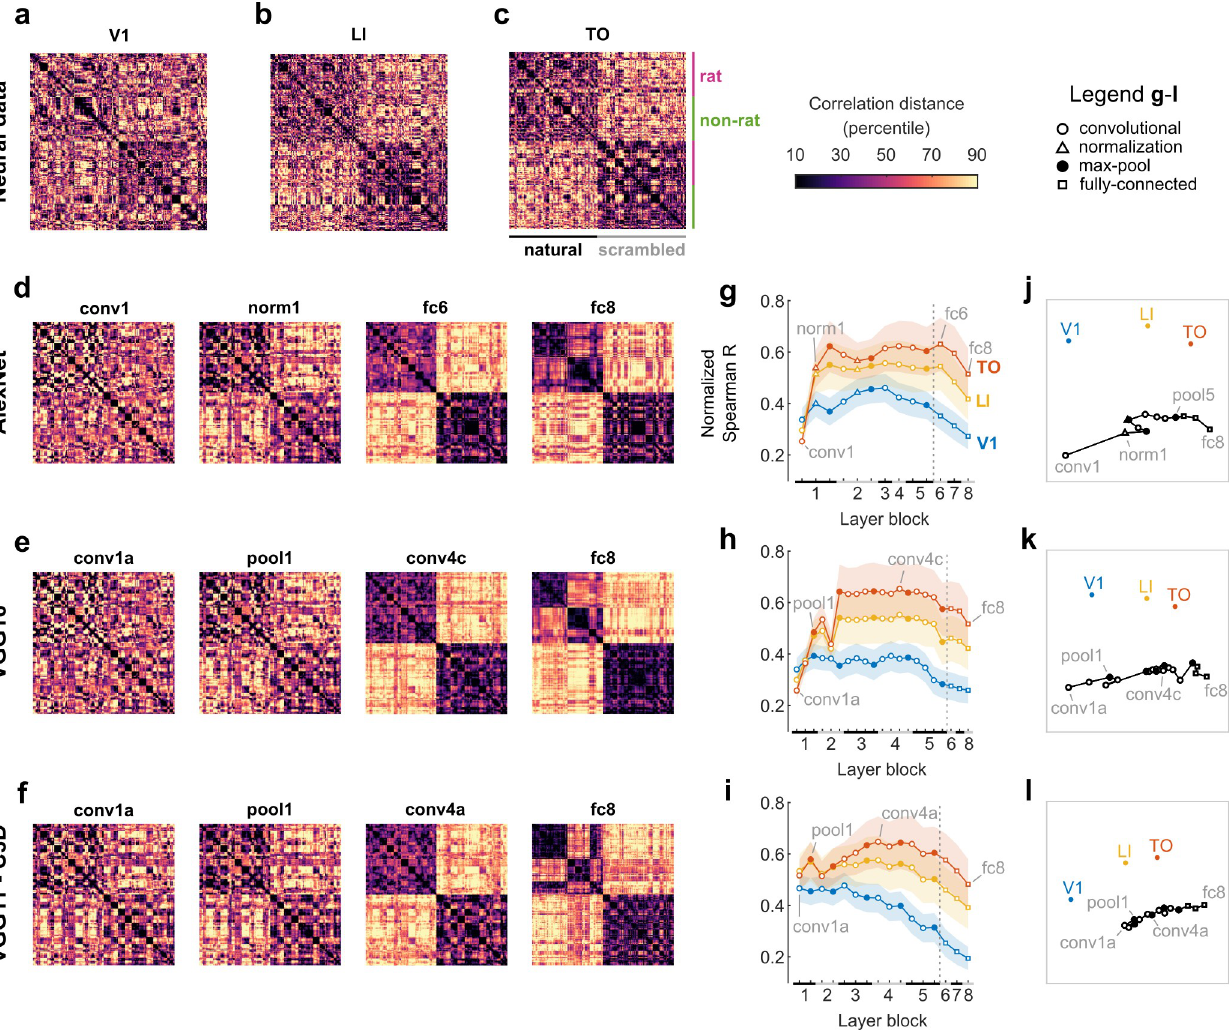
Fig 5. Neural representational dissimilarity matrices for natural and scrambled videos per putative ventral stream area change in parallel with DNN layer representations. ( a - c ) Neural RDMs for V1, LI, and TO data. Rows and columns correspond to 16-frame bins: nine per video, with first the five rat videos, then the five non-rat videos, and finally the scrambled versions of the natural videos in the same order. The color scale corresponds to percentiles of each RDM’s Pearson correlation distances (excluding the diagonal values). ( d - f ) Artificial neural network RDMs (Pearson correlation distance) for 4 layers of AlexNet, VGG16, and VGG11-C3D: the first layer, the earliest layer for which the RDM corresponds better to extra-striate (LI/TO) data, the layer with the best normalized correlation with neural data (TO in all three cases), and the last layer (fc8). ( g - i ) Spearman correlations between each artificial neural network layer RDM and each neural RDM (calculated using above diagonal elements only), normalized by each area’s noise ceiling (V1 in blue, LI in yellow, TO in red). Black and grey bars on the X-axis indicate layer blocks and markers indicate layer types (see legend insert); the division between convolutional and fully connected layer blocks is indicated by a dashed line. Grey text labels indicate the DNN RDMs shown in (d-f). Error bounds are 95% confidence intervals calculated using Jackknife standard error estimates (resampling neural units). ( j - l ) Two-dimensional representation of similarities between neural and artificial neural network RDMs, derived from applying non-metric multidimensional scaling on Spearman correlation distances between RDMs. Each marker corresponds to an RDM and similar RDMs are plotted closer together. Text labels indicate the neural RDMs and the DNN RDMs shown in (d-f).